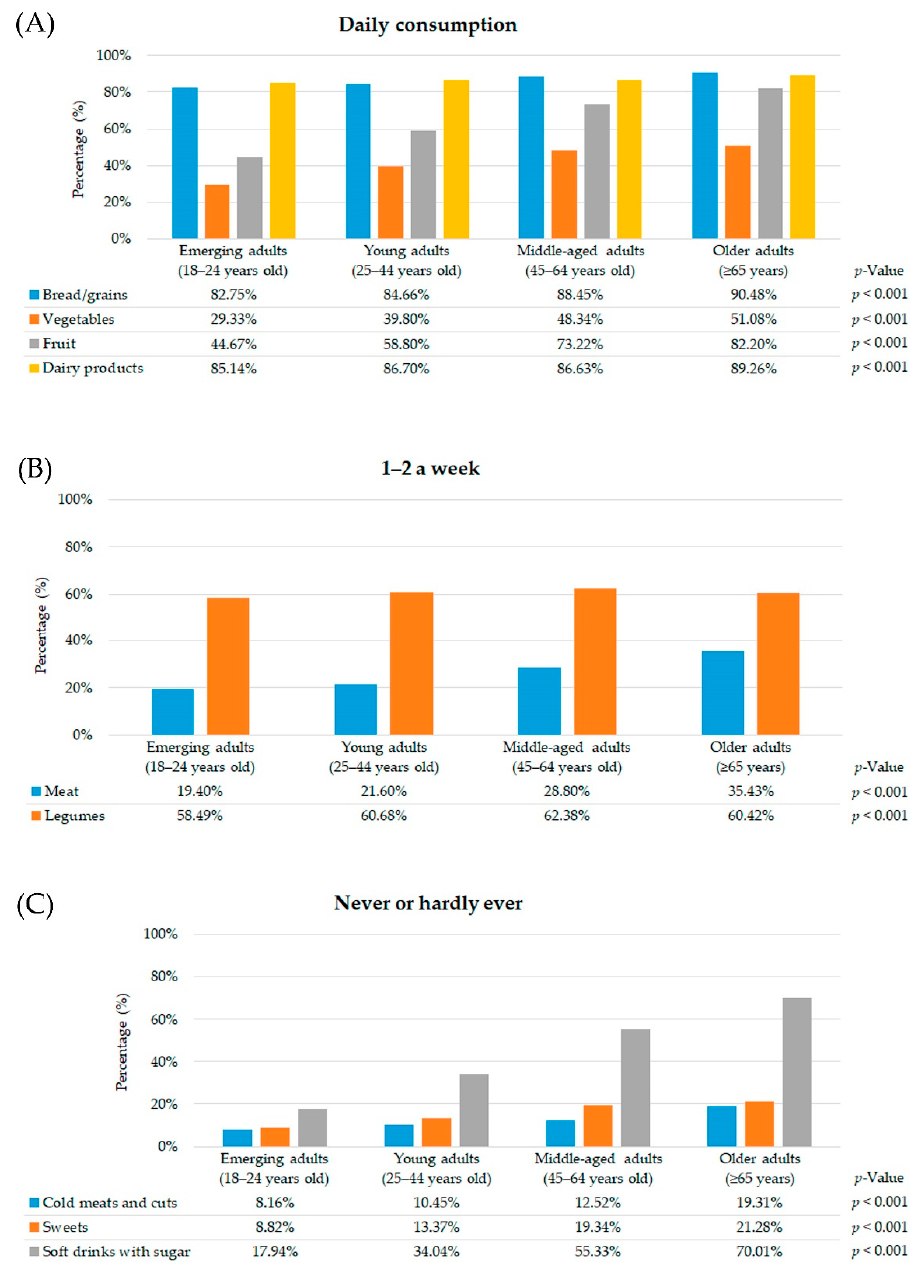
Figure 2. Frequency of food consumption according to age groups of participants without common mental disorders ( n = 48,079) (SNHS 2006, SNHS 2011/2012 and SNHS 2017) (( A ) for daily consumption, ( B ) for 1–2 a week, ( C ) for never or hardly ever).